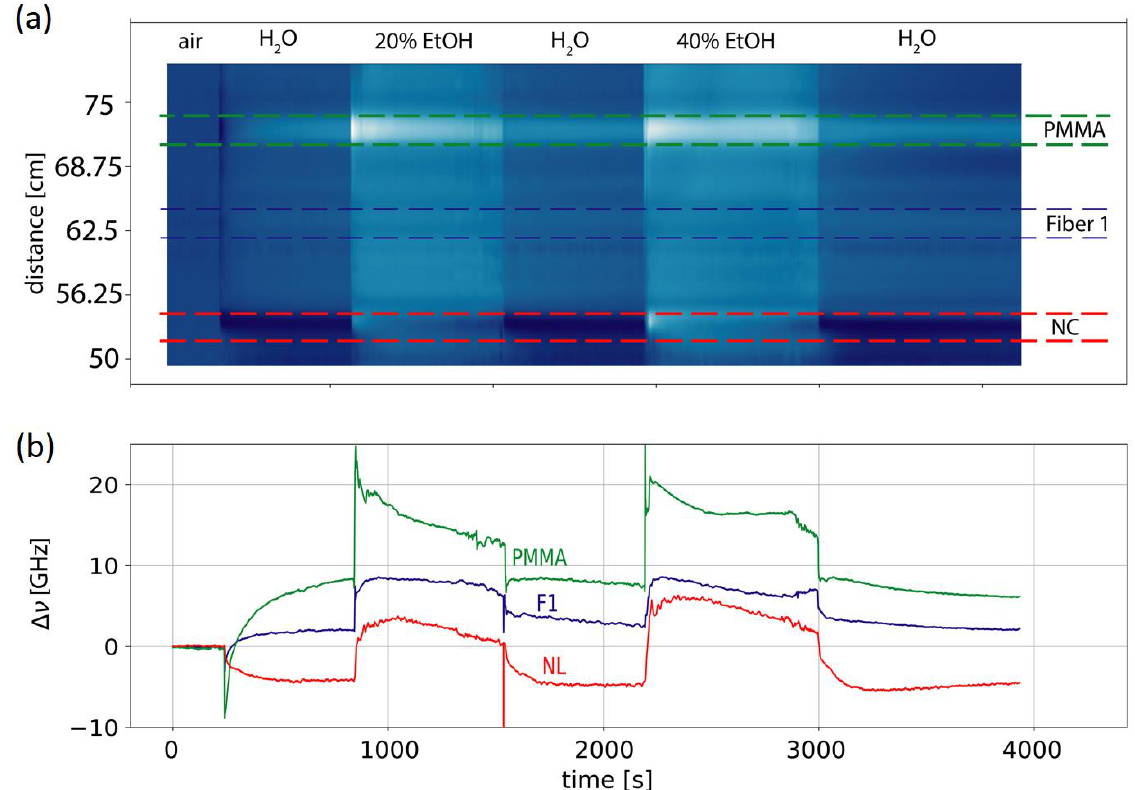
Figure 6. ( a ) Colormap showing the observed Rayleigh frequency shifts for a fiber with 3 different coatings (Original coating (ORG), polymethyl methacrylate (PMMA) and nitrocellulose (NC) coatings). A baseline was first recorded in air then the fiber is exposed for approximately 10 min long periods to water followed by 20% ethanol, water, 40% ethanol, and water as indicated. ( b ) Average frequency shifts for zones with different coatings as indicated with the dashed lines.